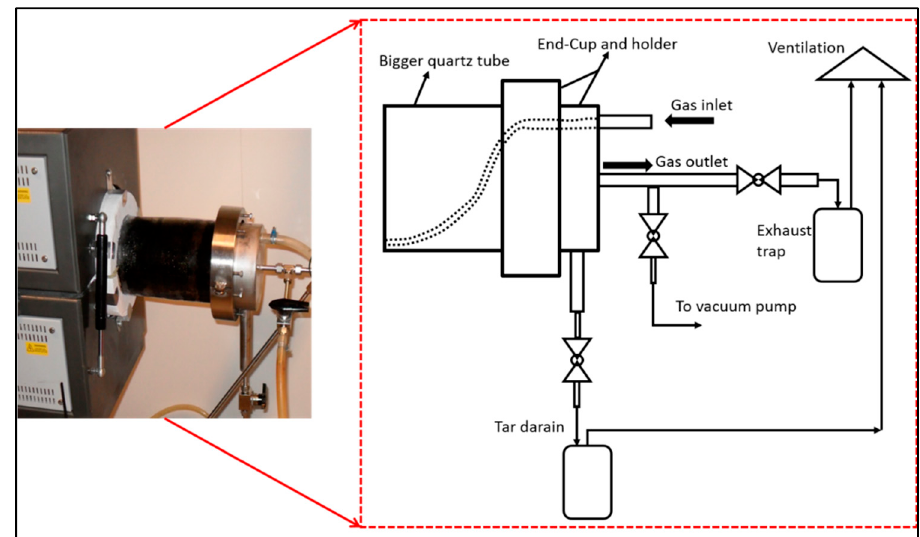
Figure 4. A photograph (on left ) and a schematic diagram (on right ) of end-cup and holder on the fiber loading-end of the furnace tube.